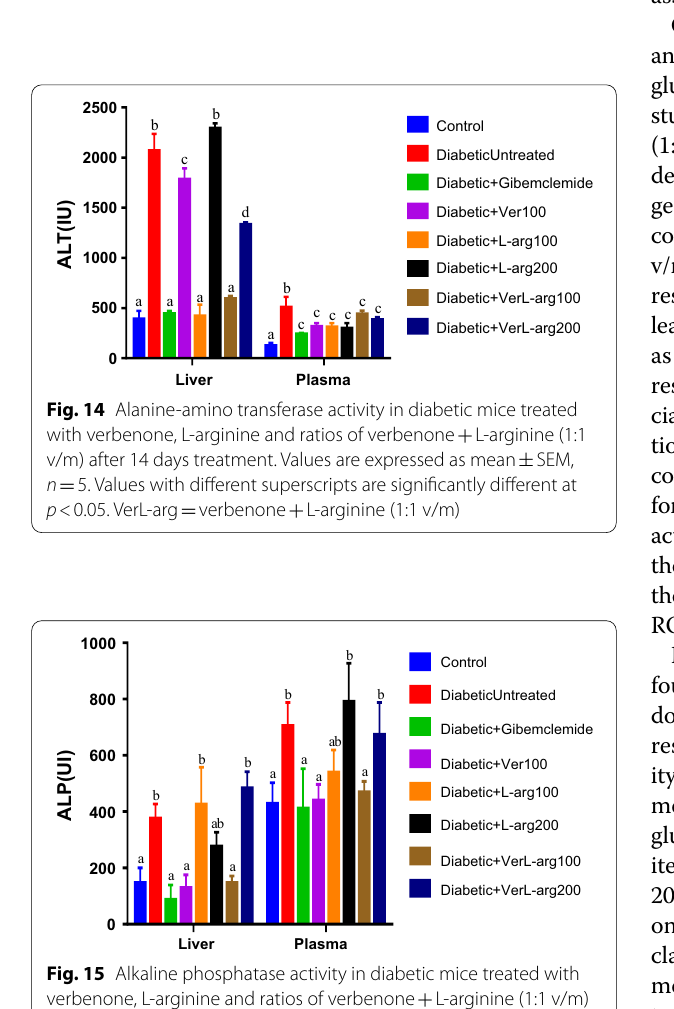
L-arginine (1:1 v/m) + SEM, n 5. ± =